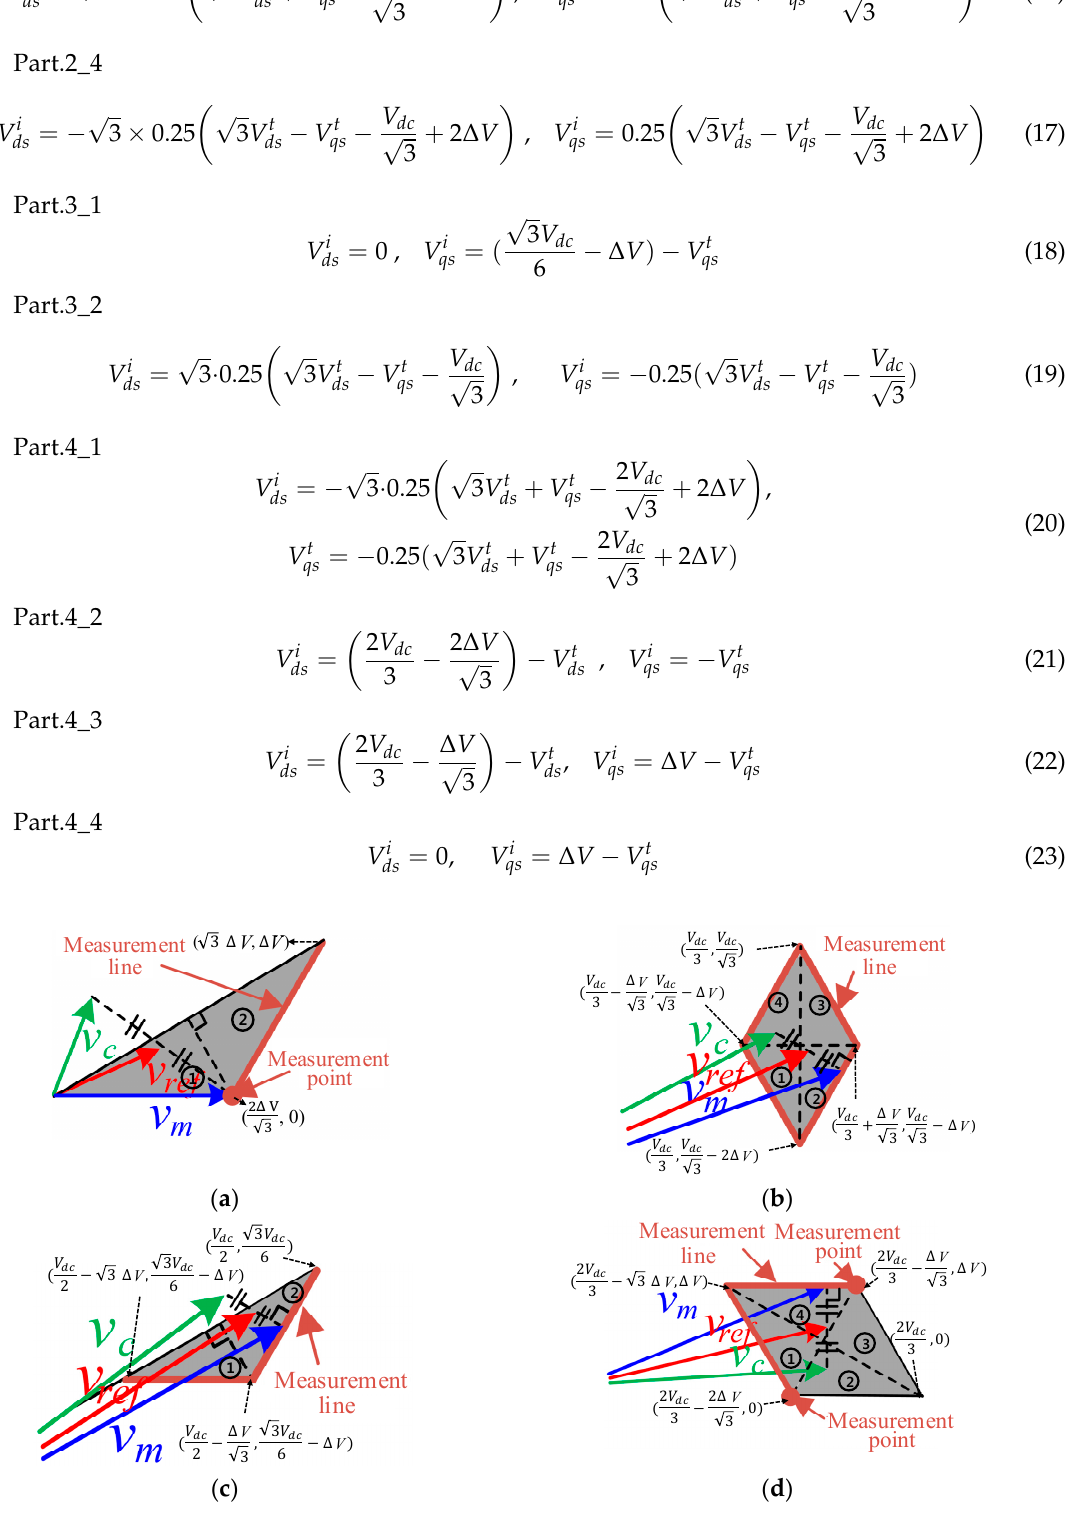
Figure 21. Optimal voltage injection method in Area 3 for each part. ( a ) Optimal voltage injection method in Part.1; ( b ) optimal voltage injection method in Part.2; ( c ) optimal voltage injection method in Part.3; ( d ) optimal voltage injection method in Part.4.